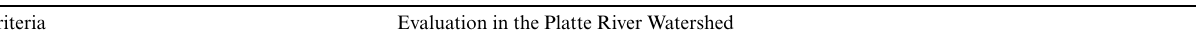
Table 2 . Analysis of adaptive capacity in the Platte River Watershed (PRW) under the Pahl-Wostl (2007, 2009) and Pahl-Wostl et al. (2010)